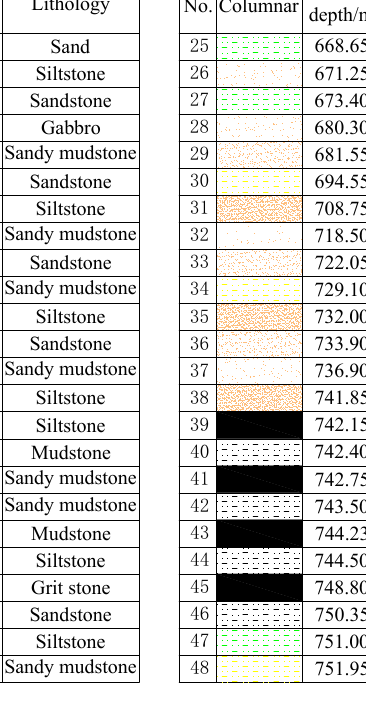
Figure 4. Histogram analysis of the overburdened rock strata in terms of columnar, buried depth, thickness, and lithology.